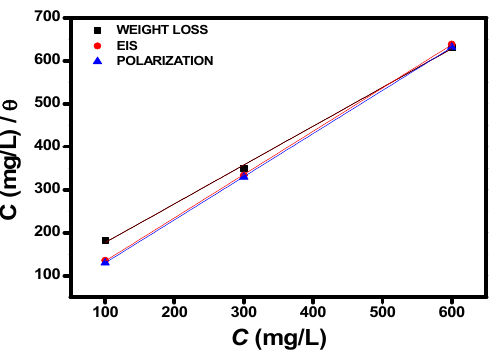
Figure 4. Langmuir adsorption isotherm plots using the values of weight loss, electrochemical impedance spectroscopy (EIS), and polarization.